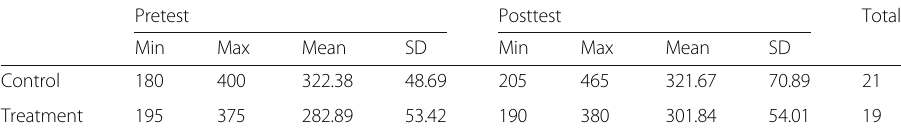
Table 3 Groups ’ Composition in terms of EI Performance across Testing Sessions Pretest Posttest Total Min Max Mean SD Min Max SD Control Treatment